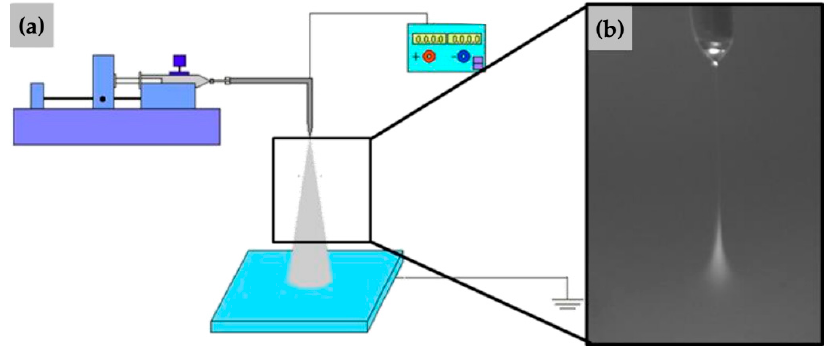
Figure 1. Schematic of the electrospray setup: ( a ) fundamental setup; ( b ) spray plume.